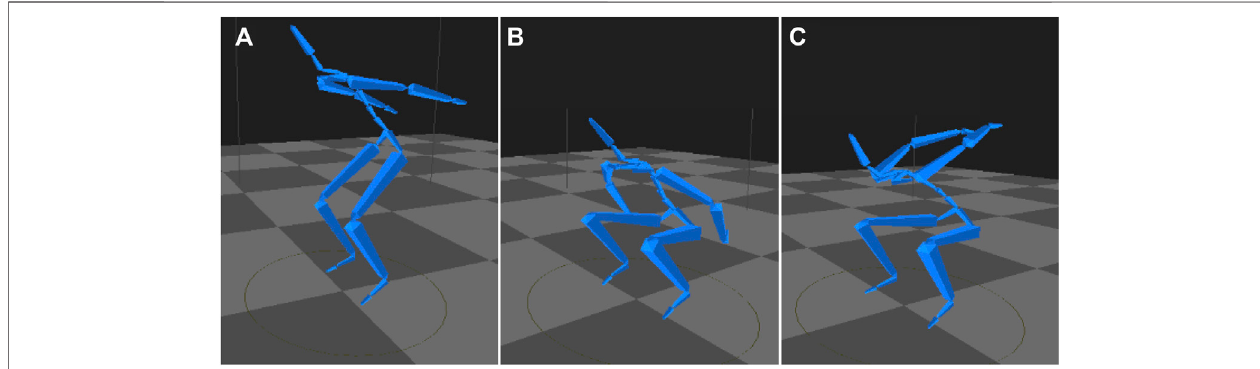
FIGURE 5 | Example of Marine Of fi cer Candidates from each cluster during max joint fl exion in the CMJ (A) (Left): Low-risk cluster (B) (Middle): Moderate-risk cluster (C) (Right):High-riskcluster;Clusternamesde fi nedbyproportionsofMOCswithMSKI( Table3 ); Low-riskcluster :lowerjoint fl exions,shortertimedurations,and higher kinetics; Moderate-risk cluster : higher joint fl exions, moderate time durations, and moderate kinetics; High-risk cluster: moderate joint fl exions, longer time durations, and lower